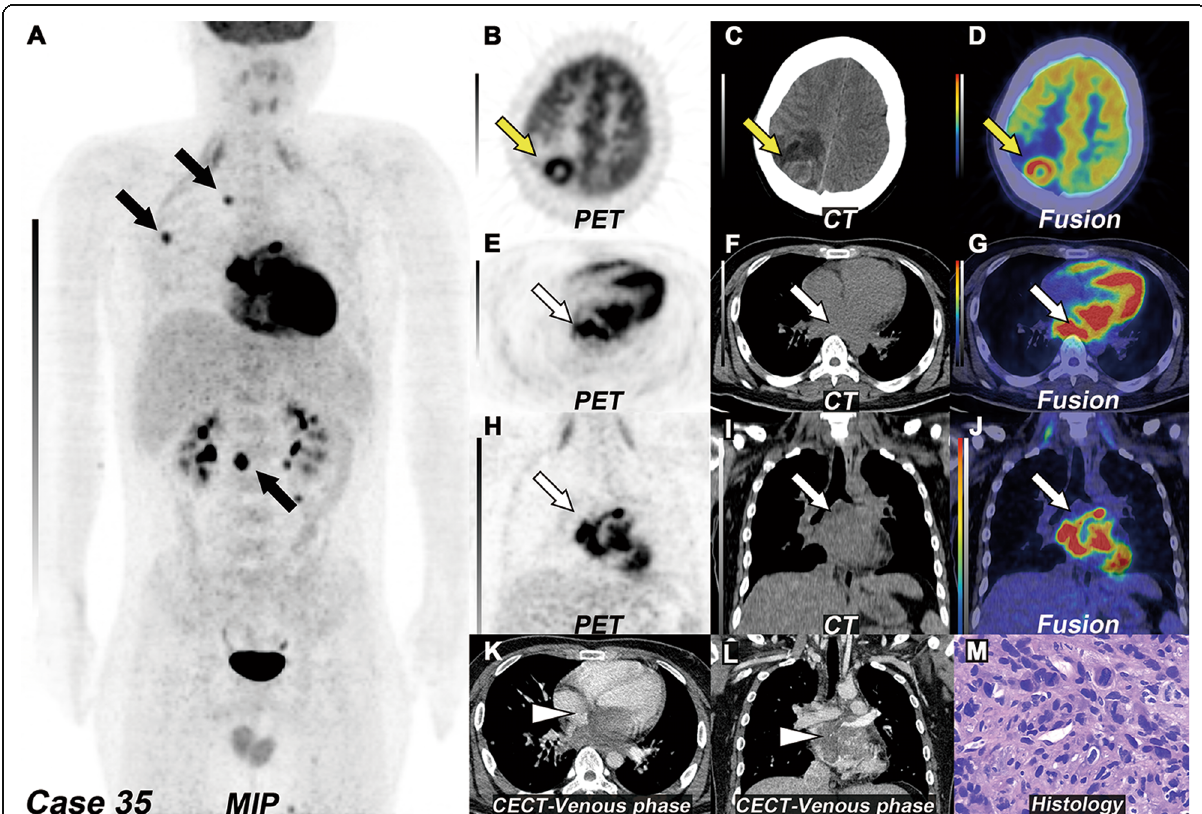
Fig. 6 Left atrial angiosarcoma with multiple metastases. a MIP of 18 F-FDG PET/CT revealed multiple bones and muscle metastasis with focal increased 18 F-FDG uptake (black arrow, SUVmax 5.6 – 10.0) and severely increased 18 F-FDG uptake by myocardium, due to lack of dietary preparation. b – d The transverse view of selected PET, CT, and fused PET/CT images revealed a brain metastasis with increased 18 F-FDG uptake in the right parietal lobe (yellow arrow). e – g The transverse and h – j coronal view of selected PET, CT, and fused PET/CT images revealed a big mass with severely increased 18 F-FDG uptake (white arrow, SUVmax 14.4), which located in the left atrium. k The transverse and l coronal view of CECT images revealed an irregular mass with moderately to intensely enhancement in the venous phase (white arrowhead). m The histopathology